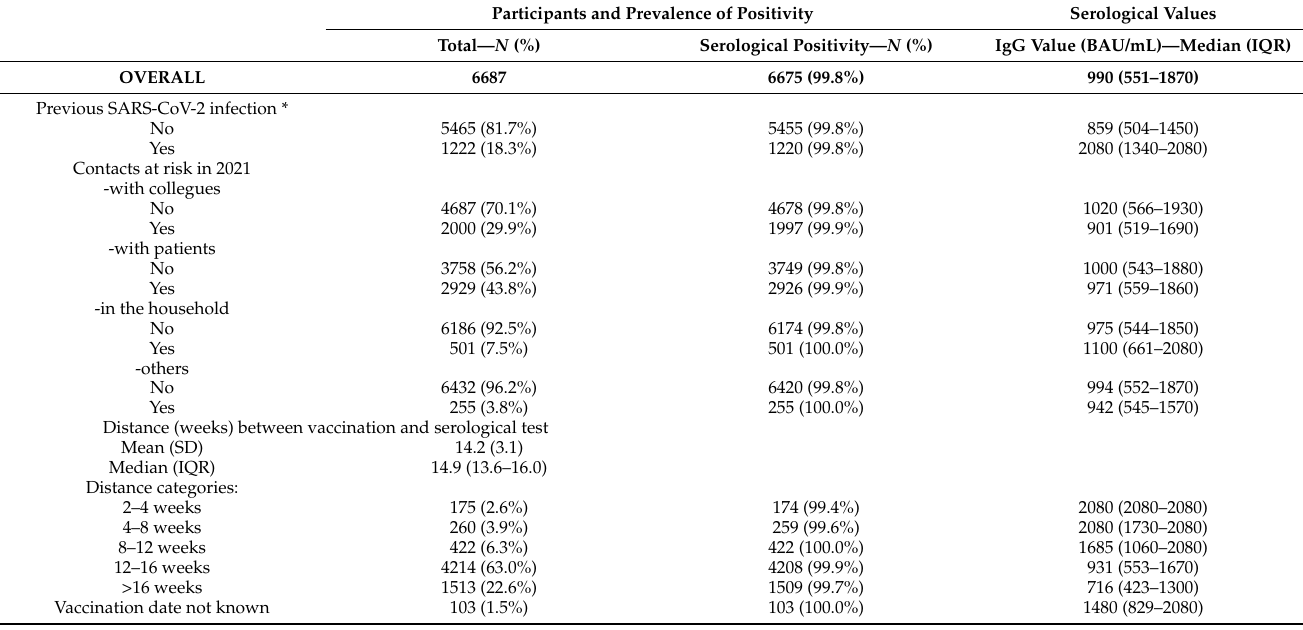
Table 2. Participants (first column), prevalence of seropositivity (second column), and serological values (third column) among 6687 vaccinated HCW of CSS participating in the serological post- vaccination survey on May 2021, by previous SARS-CoV-2 infection, contacts at risk, and distance between vaccination and serological